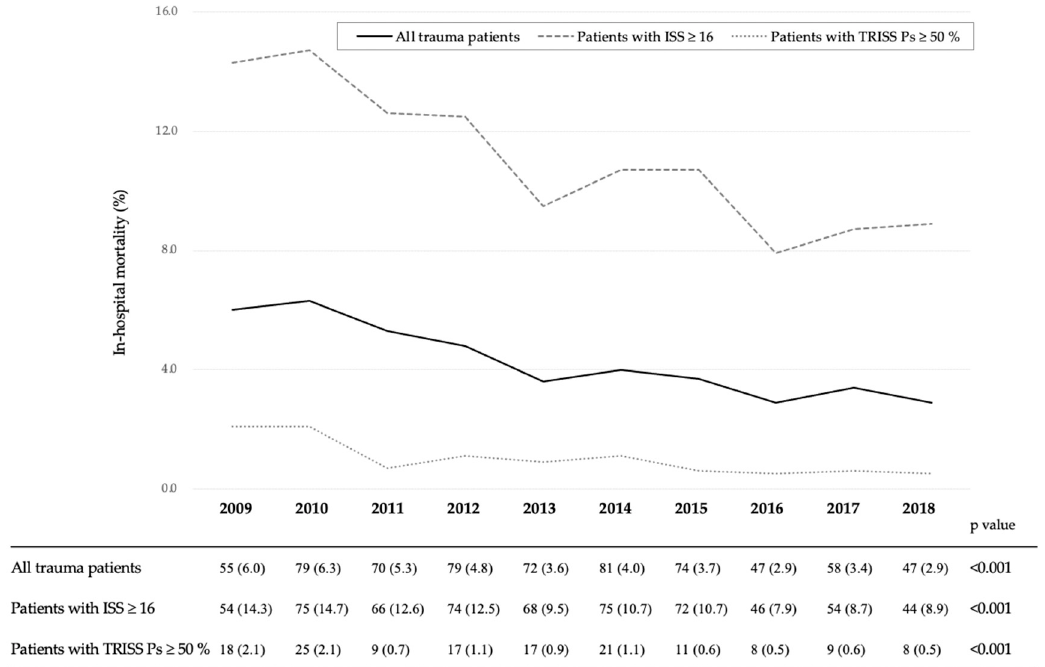
Figure 2. In-hospital mortality trends for paediatric injured patients by year. ISS, Injury Severity Score; TRISS, Trauma and Injury Severity Score; Ps, probability of survival.